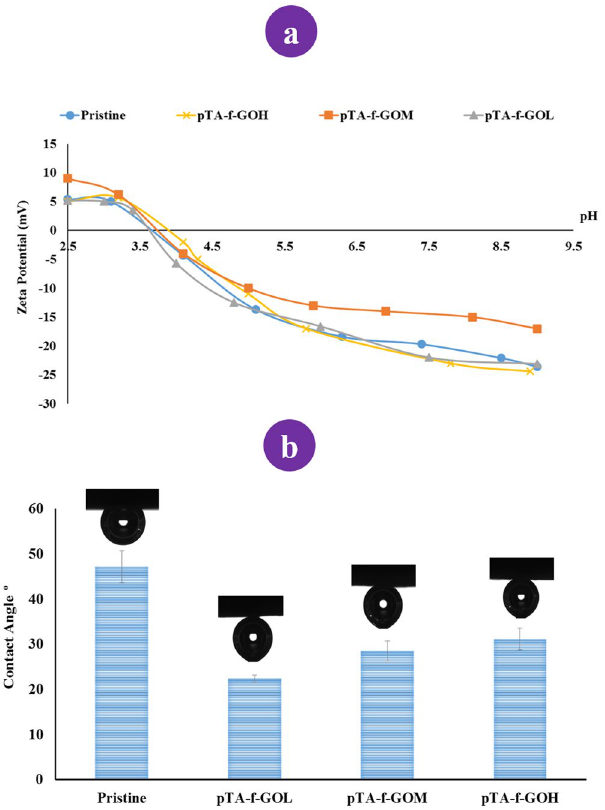
Figure 4. ( a ) Surface charge and ( b ) wettability measurements of pristine and pTA-f-GO RO TFNC fabricated